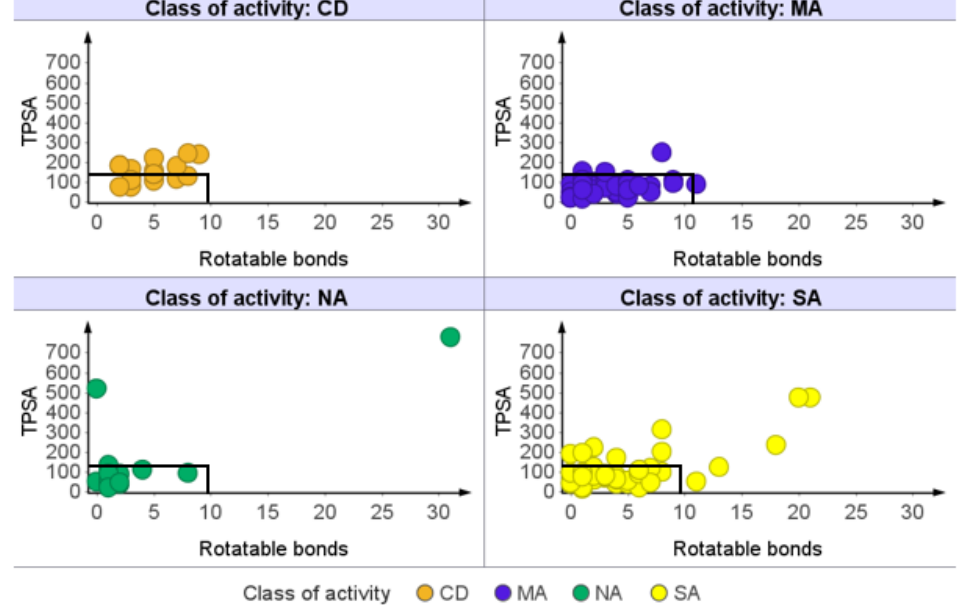
Overall, 86% of AMNPs and 53% of CDs were within the space of the rule. For the AMNP categories, all compounds in NA, except tannic acid (TPSA = 777.98 and RTB = 31) and punicalagin (TPSA = 518.76 and RTB = 0), were in compliance with Veber’s rule. Ad-